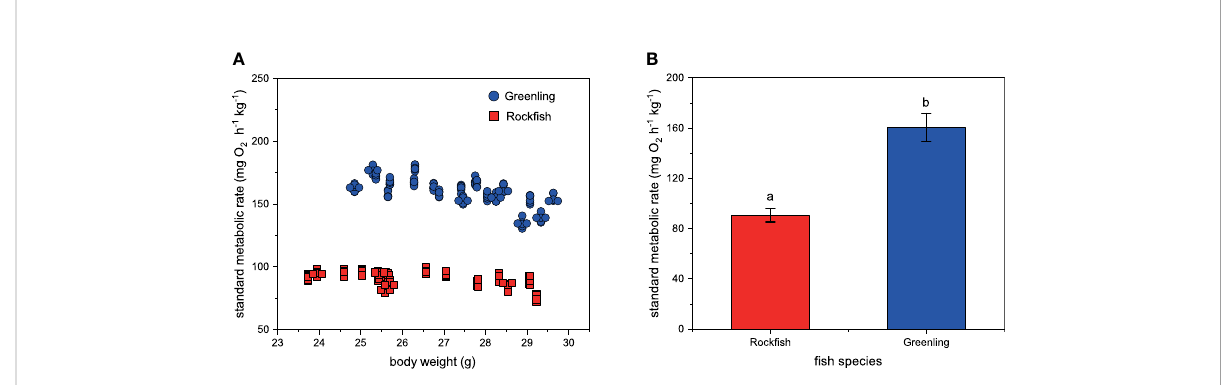
FIGURE 4 The standard metabolic rate (mg O 2 h -1 kg -1 ) of black rock fi sh and fat greenling. Plot (A) presented the changes in standard metabolic rate along with the changes in fi sh body weight. Plot (B) presented the metabolic difference between the two fi sh species, and different letters indicate signi fi cant differences. n = 20. Data are presented as means ±